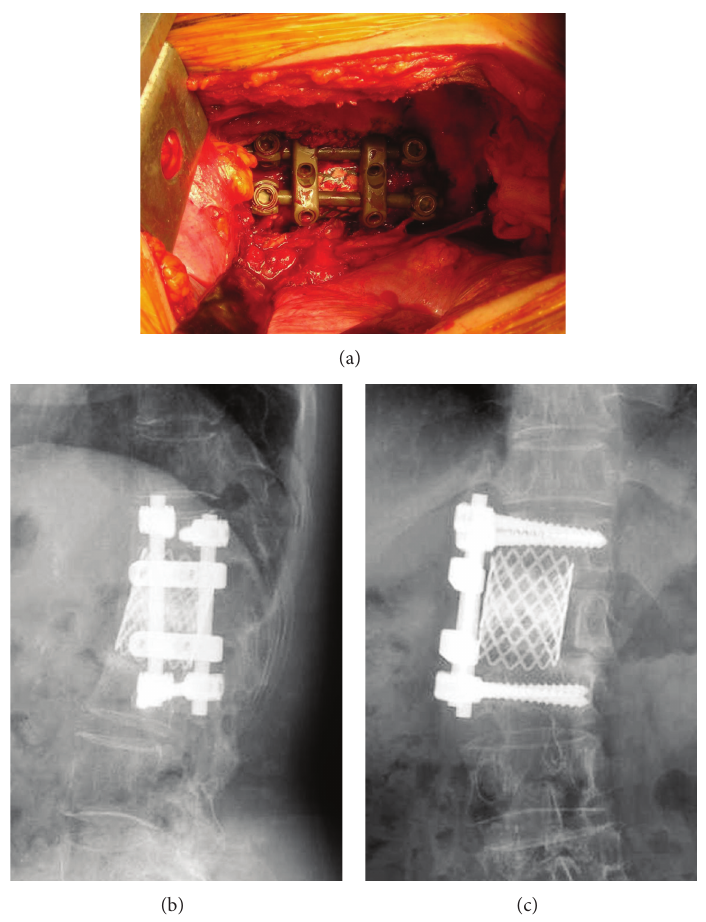
Figure 2: Anterior reconstruction from T12 to L2 using iodine-supported instrumentation. (a) Operative photograph. (Right side is directed cranially, and upper side is directed dorsally.) Postoperative radiographs of the lumbar spine. (b) Lateral view. (c) Anteroposterior view.